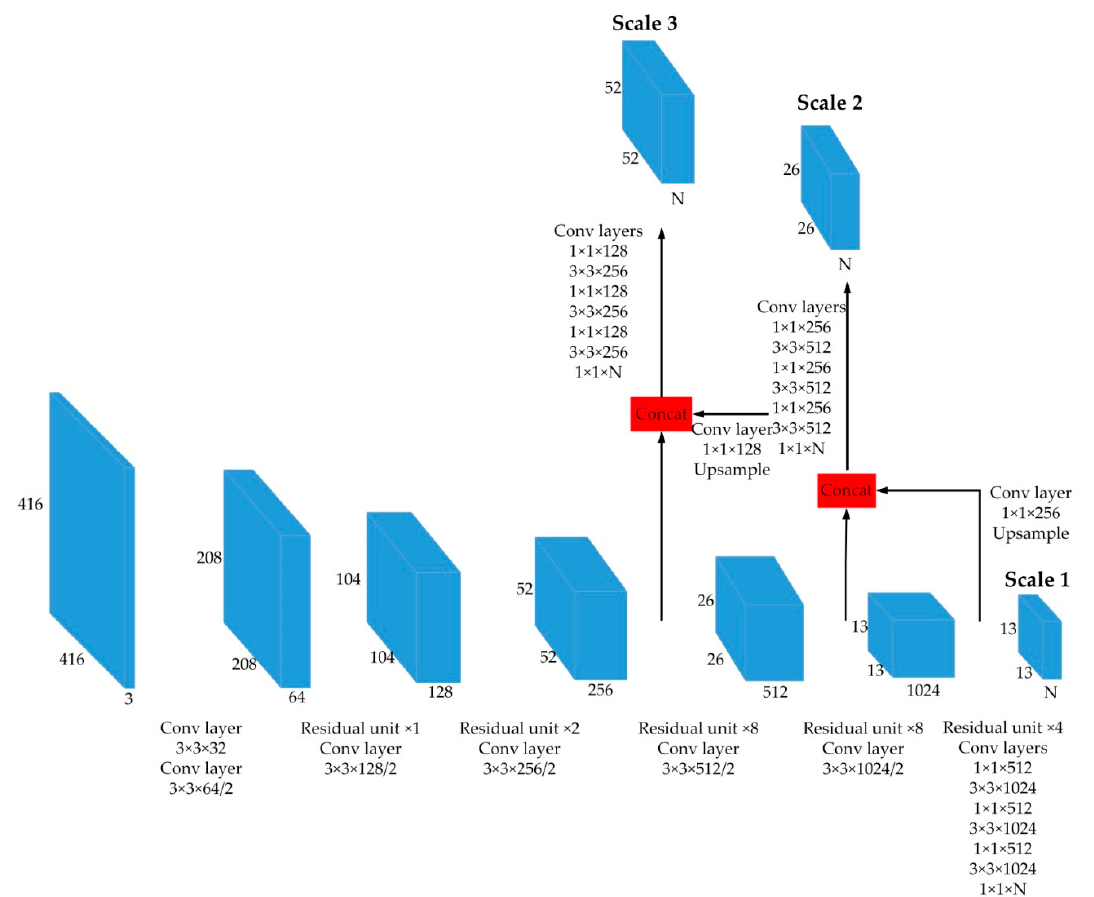
Figure 2. The network of YOLO V3.